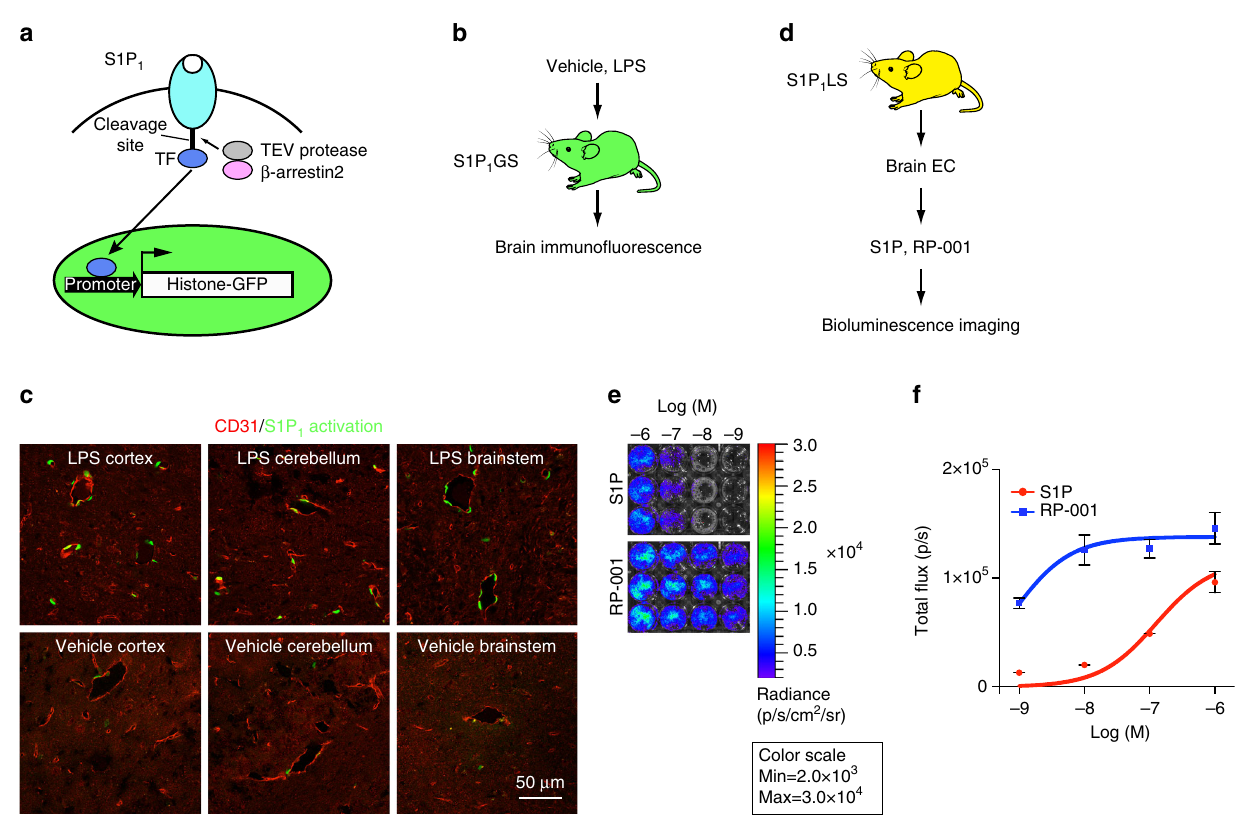
Fig. 6 S1P 1 activation by LPS in the brain. a Schematic of the design to monitor S1P 1 activation in S1P 1 GFP signaling mice. S1P 1 is fused to a transcription factor (TF) via a protease recognition sequence. Ligand binding to the receptor stimulates the recruitment of a β -arrestin2 – TEV protease fusion protein, triggering the release of the transcription factor from the C terminus of modi fi ed S1P 1 . The transcription factor stimulates expression of a histone-GFP reporter gene, fl uorescently labeling cell nuclei. b LPS or vehicle was injected intraperitoneally into S1P 1 GFP signaling (S1P 1 GS) mice, and the brains were harvested 7 days after injection and examined by immuno fl uorescence. The tissues of three mice injected with LPS and three mice injected with vehicle were examined. c Representative histological sections were immunostained with antibodies to CD31, and the images of cerebral cortex, cerebellum, and brainstem were captured using an inverted laser scanning confocal microscope. Scale bar, 50 μ m. d Brain endothelial cells (EC) were isolated from S1P 1 luciferase signaling (S1P 1 LS) mice, grown in triplicate in 24-well plates, treated with S1P or RP-001 and D-luciferin, and immediately subjected to BLI. e Bioluminescence images of the cells exposed to the indicated concentrations of S1P or RP-001 represent a 15-min acquisition. The experiment was repeated twice. f The bioluminescence activity was quanti fi ed by determining the total fl ux (photons/sec; p/sec). Data represent the mean ± SEM, n =